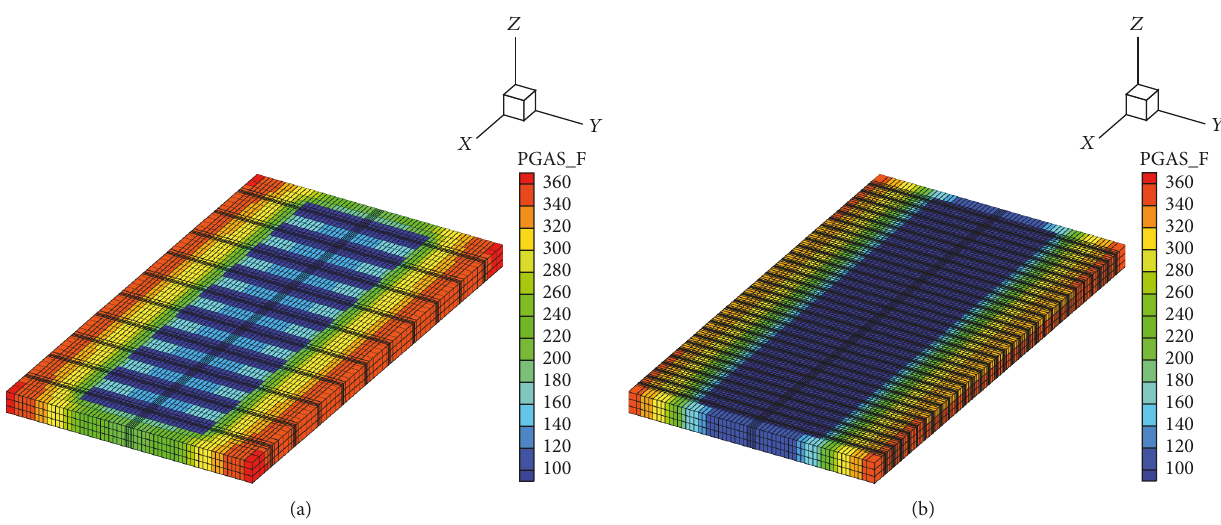
Figure 12: The pressure distribution with different hydraulic fracturing stage number: (a) 10 and (b) 20.